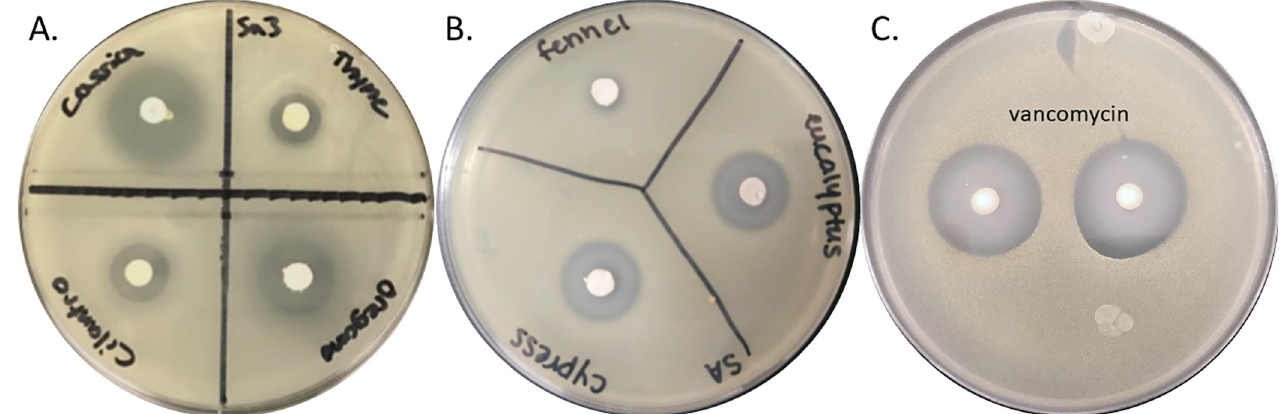
Fig 2. PEO-loaded beads inhibit S . aureus growth in agar pour plates. Representative images of Cassia, Cilantro, Oregano, and Thyme (A), Fennel, Eucalyptus, and Cypress (B), versus the vancomycin 30 μ g control (C, in duplicate) loaded beads inhibiting S . aureus growth in three dimensions.